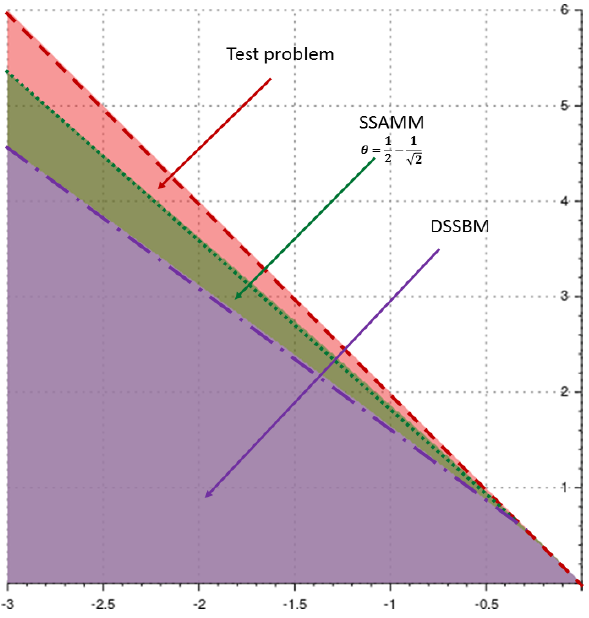
Figure 5. Real MS-stability regions of drifting split-step backward Milstein (DSSBM), split-step Adams–Moulton–Milstein (SSAMM) and the test